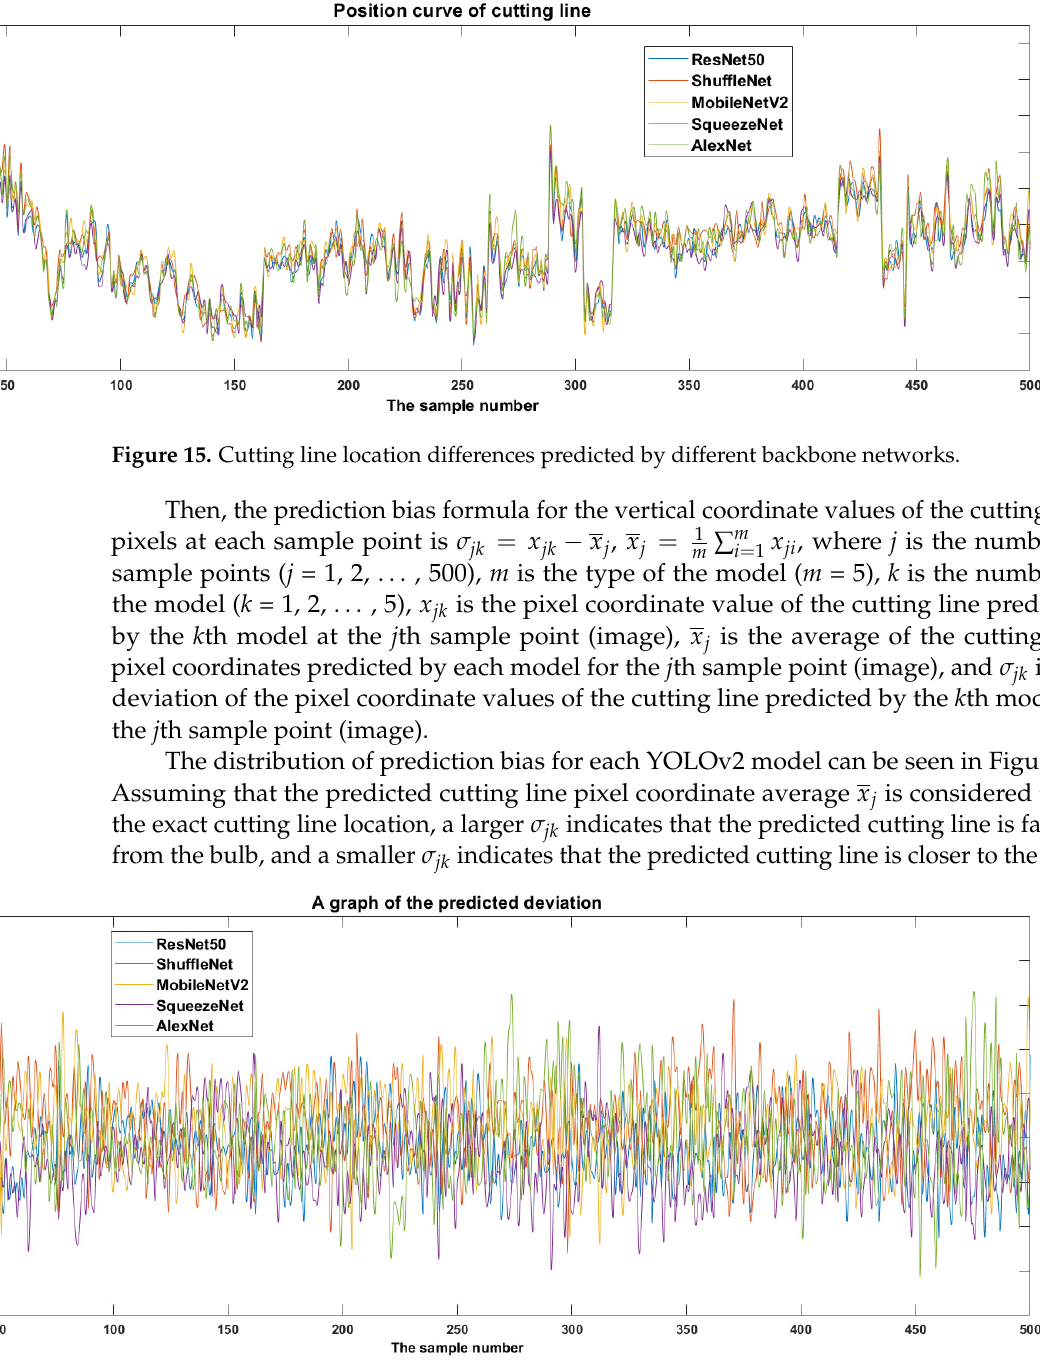
Figure 14. Prediction of cutting line location by different backbone networks.